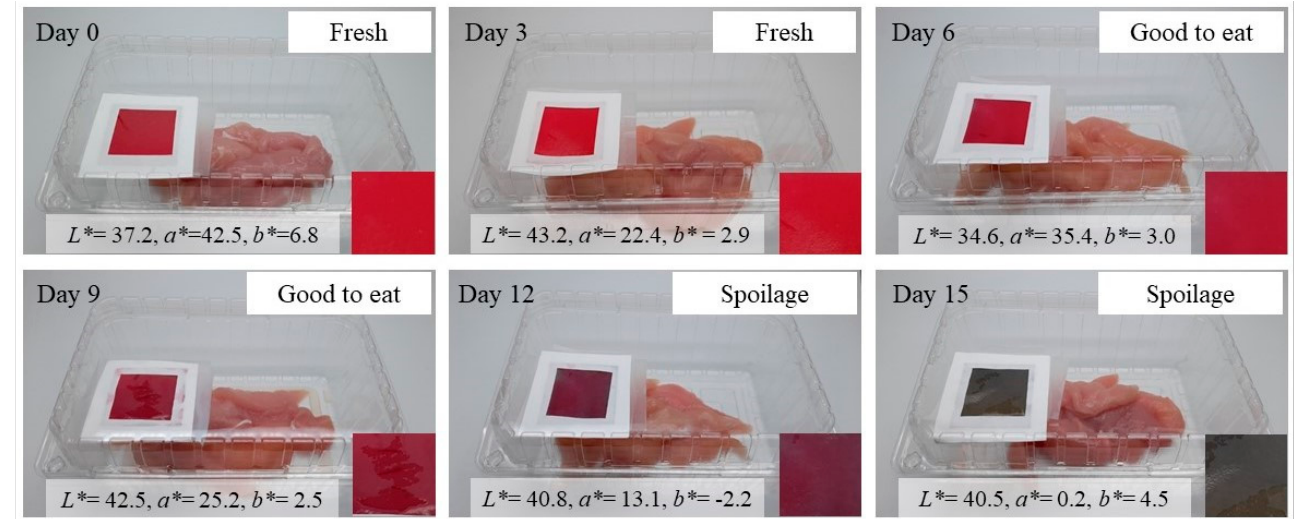
Figure 8. The color change of the RA-H20MB indicator and freshness/spoilage status of chicken tenderloin stored at 4 °C.